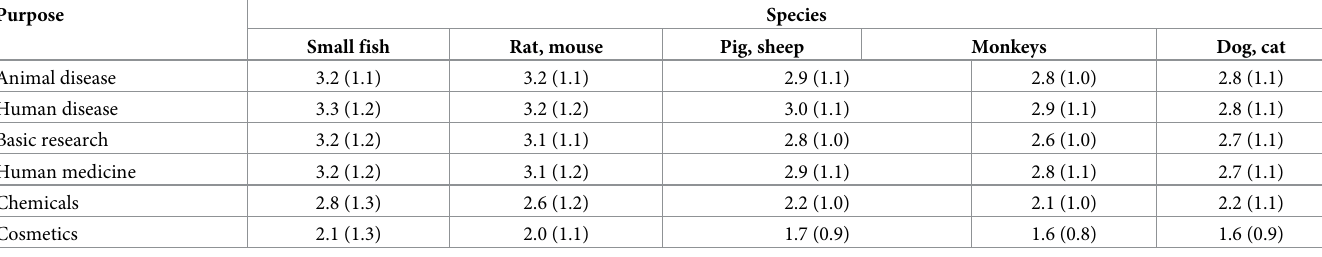
Table 4. Faculty ARAS-PD scores as a function of research purpose and species (1–5 scale) 1 .